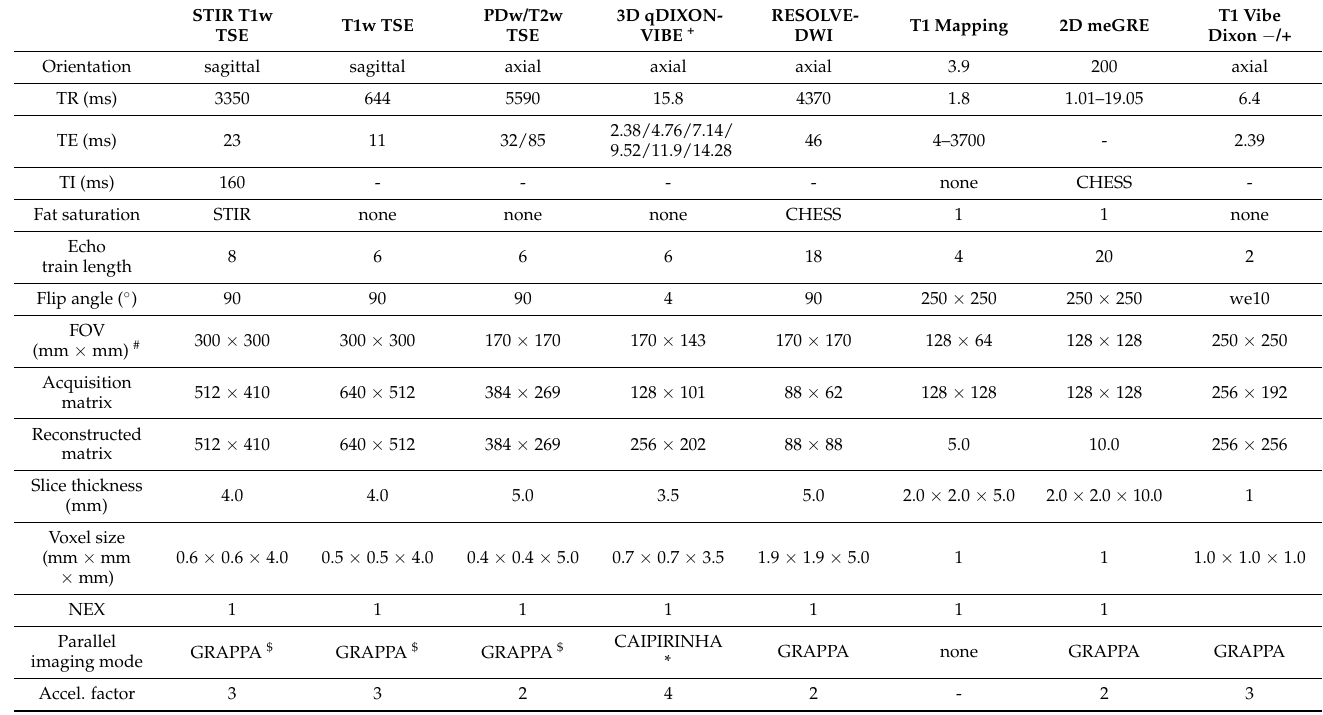
Table 1. MRI sequence parameters’